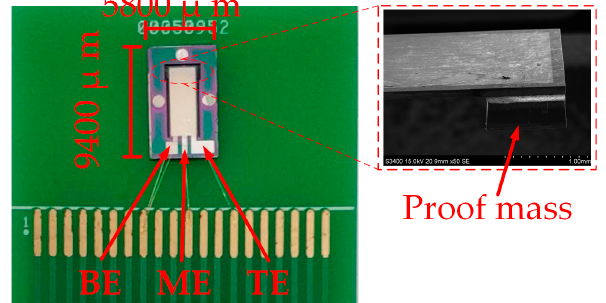
Figure 5. Photograph of packaged acceleration sensor chip.